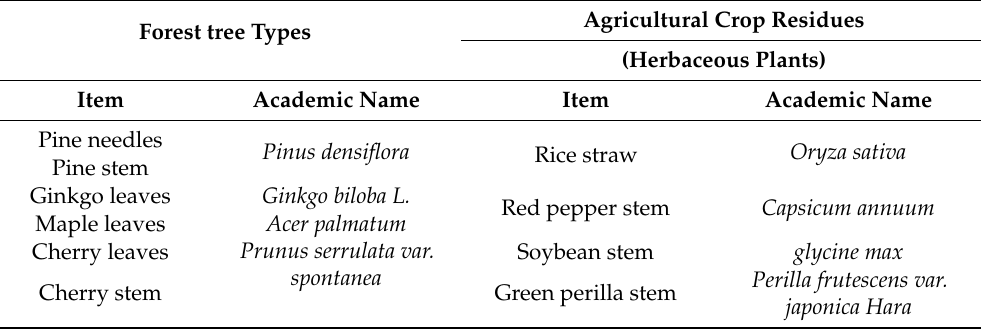
Figure 1. Schematic diagram of biomass burning chamber. Table 1. Research materials used in biomass burning.